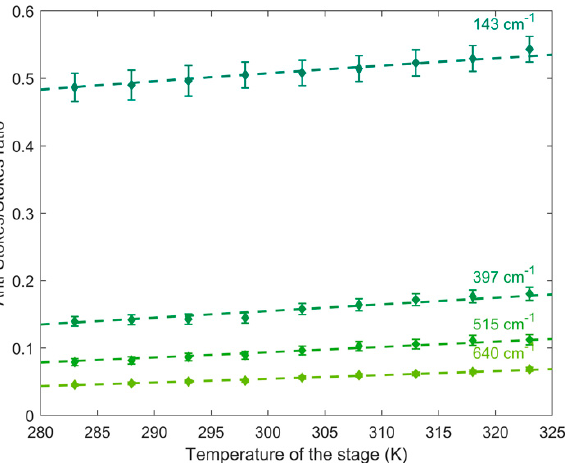
Figure 6. Experimental anti-Stokes/Stokes ratios in the range 283–323 K for the Raman modes of anatase, at 143 cm − 1 (circles), 397 cm − 1 (down-pointing triangles), 515 cm − 1 (squares) and 640 cm − 1 (up-pointing triangles) collected at λ exc = 514.5 nm.